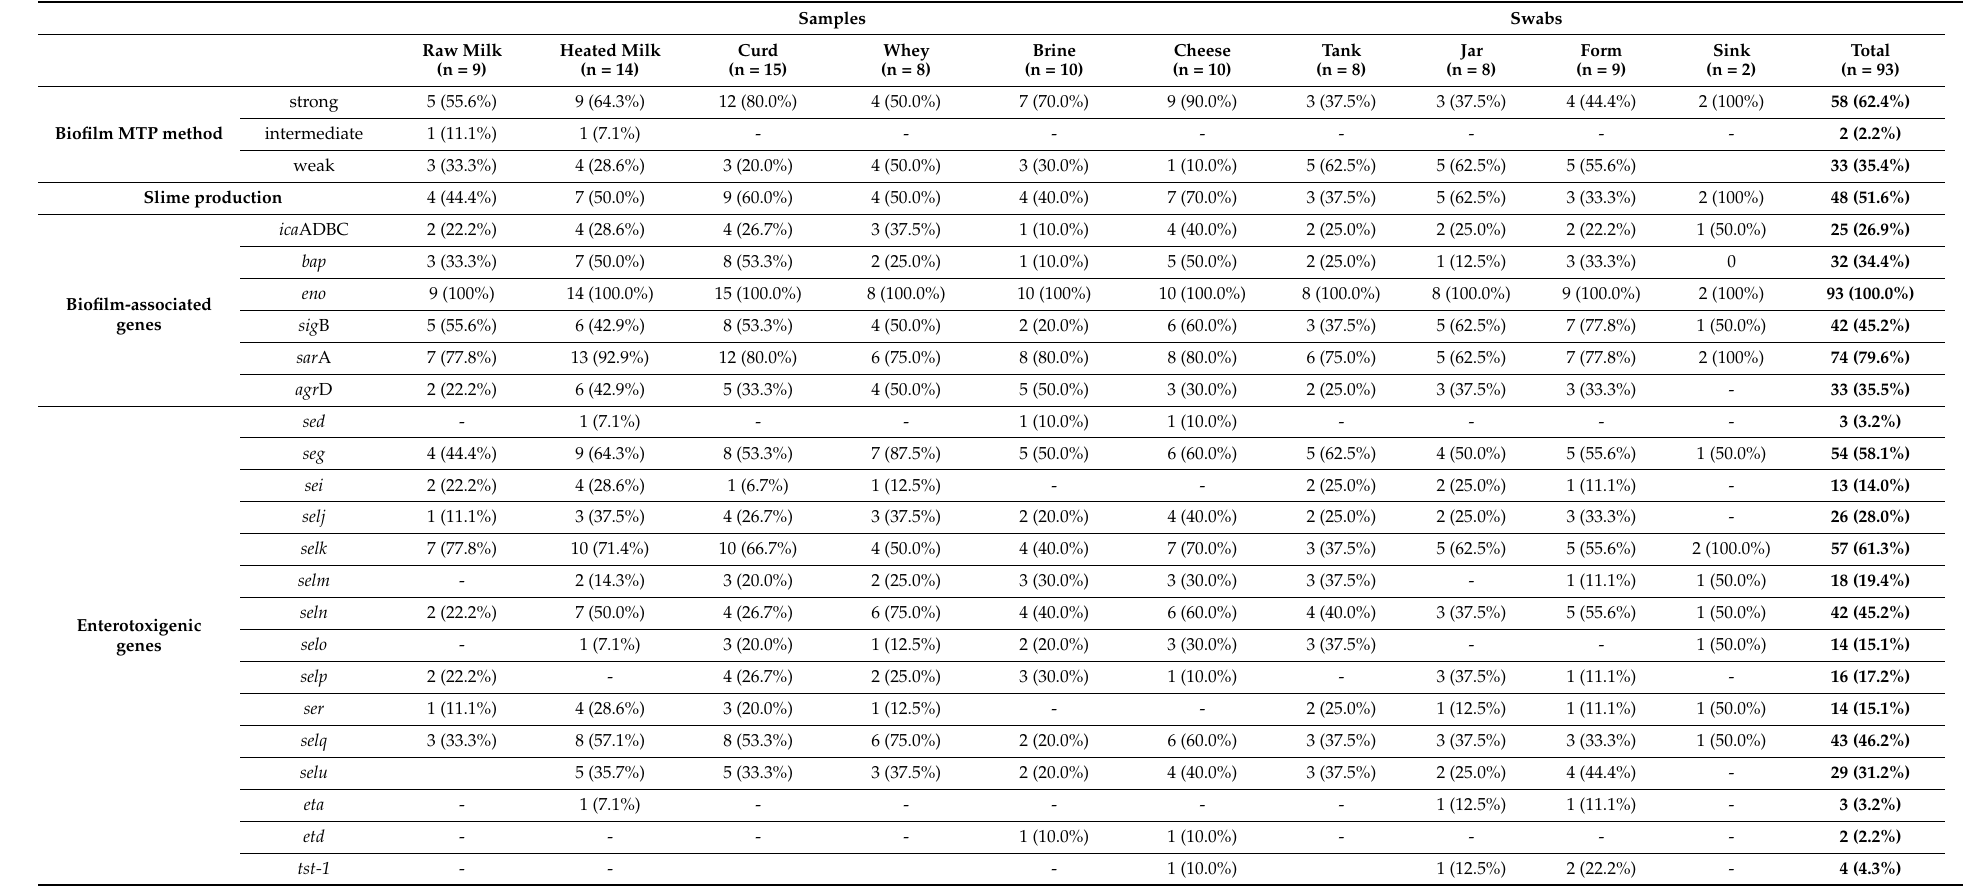
Table 4. Virulence characteristics among S. aureus